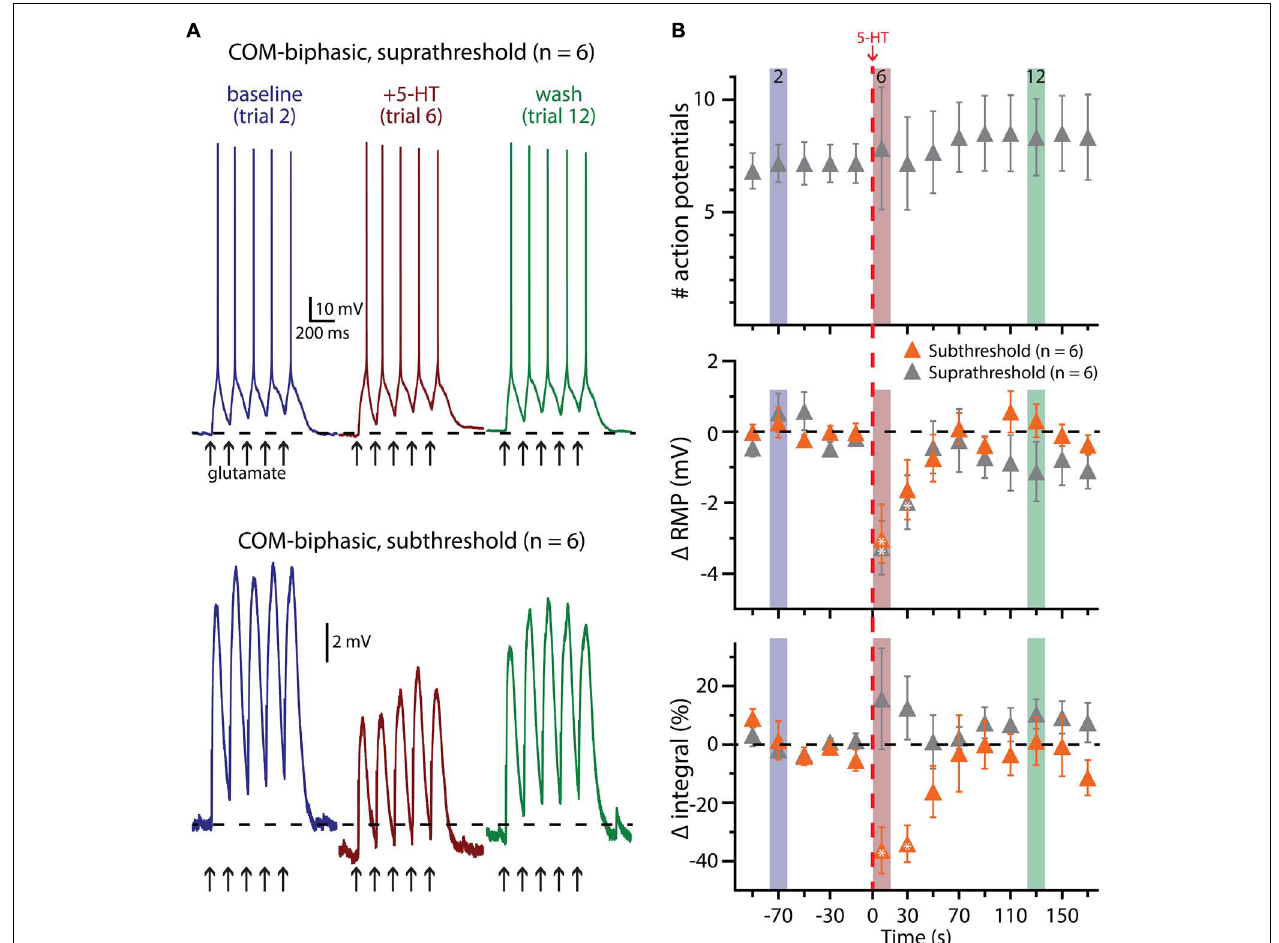
top), RMPs (middle), and response integrals (bottom) in COM-biphasic L5PNs receiving suprathreshold (gray symbols) or subthreshold (orange symbols) over time. 5-HT (red dashed-line) failed to enhance AP genesis, but did hyperpolarize COM-biphasic neurons, and reduced response integrals to subthreshold glutamate applications. Asterisks indicate significant changes from baseline values ( p < 0.05).